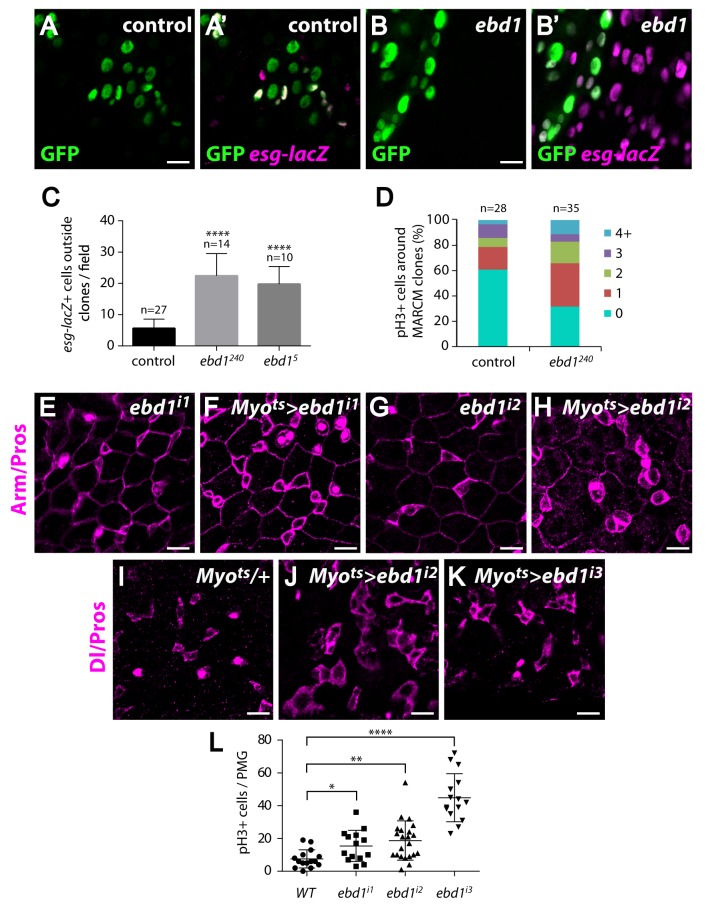
Ebd1 regulates stem cell proliferation non-autonomously.(A-B’) There are more progenitor cells, marked with esg-lacZ (magenta), near ebd1240 mutant clones (GFP labeled clones in green, B and B’), than near wild-type (control) clones (green, A and A’). (C) Quantification of the number of esg-lacZ positive cells around control clones and around clones of two independent ebd1 null alleles, ebd1240 and ebd15. **** P<0.0001 (t-test). (D) More pH3 positive cells are detected around ebd1 mutant clones than around control clones, indicating that the rate of cell division is higher around the mutant clones. (E-H) RNAi-mediated disruption of ebd1 expression, specifically in ECs, leads to increased numbers of progenitors (compare F to E, and H to G). Progenitor cells are identified as small cells with strong Arm staining and lack of Prospero staining (magenta). (I-K) RNAi-mediated disruption of ebd1 expression, specifically in ECs, leads to increased numbers of ISCs (compare J and K to I). ISCs are stained with Dl (magenta) and EEs with Prospero (magenta). (L) Increased rates of ISC proliferation are observed when ebd1 expression is knocked down with three independent RNAi lines. Proliferation rate is assessed by the number of pH3 positive cells in the posterior midgut (PMG). **** P<0.0001, ** P<0.01, * P<0.05 (t-test). Scale bars in (A-B’) and (E-K) are 10 μm. Genotypes: (A-B’) control: y w hs-flp/+; tub-Gal4 UAS-GFP/esg-lacZ; FRT2A tub-Gal80/FRT2A
ebd1 (ebd1240):
y w hs-flp/+; tub-Gal4 UAS-GFP/esg-lacZ; FRT2A tub-Gal80/ebd1240
FRT2A
ebd15: y w hs-flp/+; tub-Gal4 UAS-GFP/esg-lacZ; FRT2A tub-Gal80/ebd15
FRT2A (E-K) ebd1i1: UAS-ebd1 RNAi#1/+
Myo>ebd1i1: Myo1A-Gal4 UAS-GFP tub-Gal80ts/+; UAS-ebd1 RNAi#1/+
ebd1i2: UAS-ebd1 RNAi#2/+
Myo>ebd1i2: Myo1A-Gal4 UAS-GFP tub-Gal80ts/+; UAS-ebd1 RNAi#2/+
Myo>+:
Myo1A-Gal4 UAS-GFP tub-Gal80ts/+
Myo>ebd1i3: Myo1A-Gal4 UAS-GFP tub-Gal80ts/+; UAS-ebd1 RNAi#3/+ (L) WT:
Myo1A-Gal4 UAS-GFP tub-Gal80ts/+
ebd1i1: Myo1A-Gal4 UAS-GFP tub-Gal80ts/+; UAS-ebd1 RNAi#1/+
ebd1i2: Myo1A-Gal4 UAS-GFP tub-Gal80ts/+; UAS-ebd1 RNAi#2/+
ebd1i3: Myo1A-Gal4 UAS-GFP tub-Gal80ts/+; UAS-ebd1 RNAi#3/+.